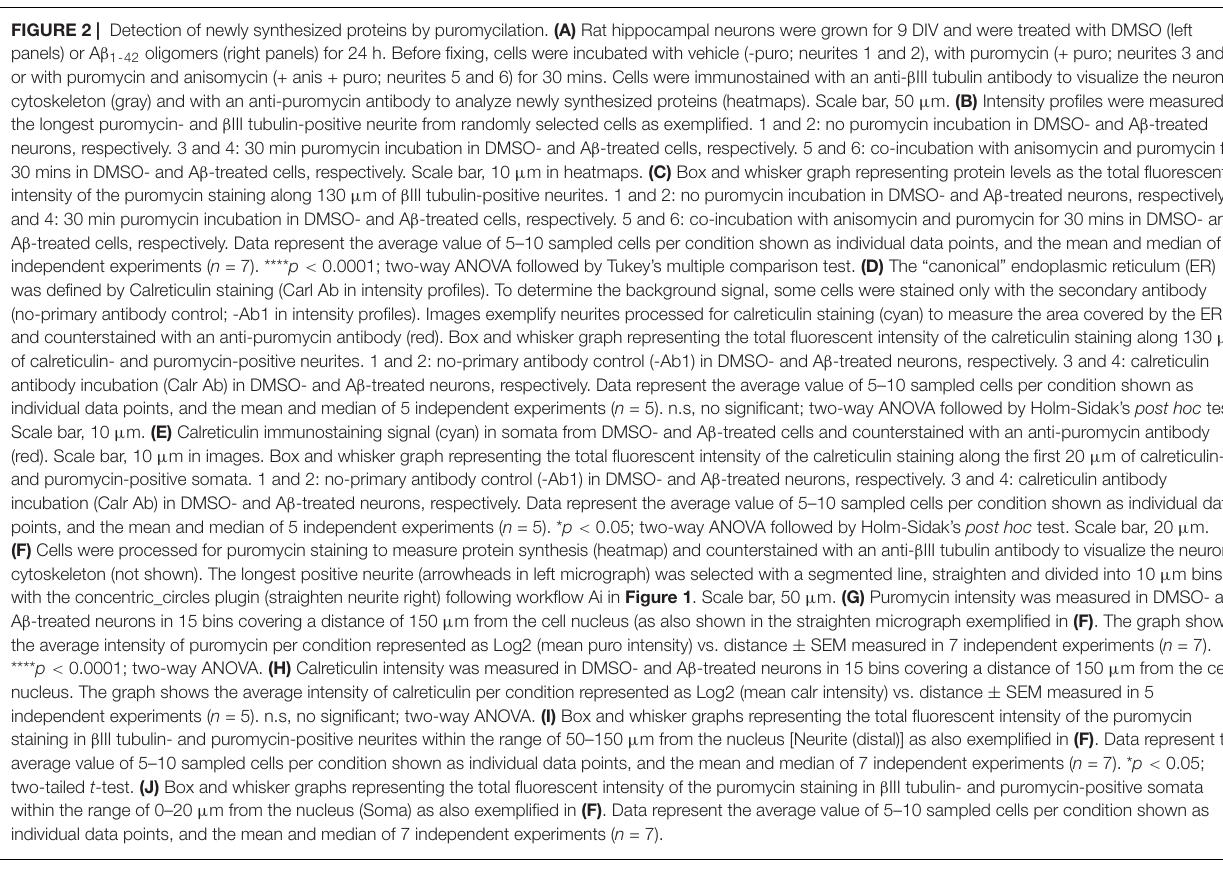
FIGURE 2 | Detection of newly synthesized proteins by puromycilation. (A) Rat hippocampal neurons were grown for 9 DIV and were treated with DMSO (left panels) or A β 1 - 42 oligomers (right panels) for 24 h. Before fixing, cells were incubated with vehicle (-puro; neurites 1 and 2), with puromycin (+ puro; neurites 3 and 4) or with puromycin and anisomycin (+ anis + puro; neurites 5 and 6) for 30 mins. Cells were immunostained with an anti- β III tubulin antibody to visualize the neuronal cytoskeleton (gray) and with an anti-puromycin antibody to analyze newly synthesized proteins (heatmaps). Scale bar, 50 µ m. (B) Intensity profiles were measured in the longest puromycin- and β III tubulin-positive neurite from randomly selected cells as exemplified. 1 and 2: no puromycin incubation in DMSO- and A β -treated neurons, respectively. 3 and 4: 30 min puromycin incubation in DMSO- and A β -treated cells, respectively. 5 and 6: co-incubation with anisomycin and puromycin for 30 mins in DMSO- and A β -treated cells, respectively. Scale bar, 10 µ m in heatmaps. (C) Box and whisker graph representing protein levels as the total fluorescent intensity of the puromycin staining along 130 µ m of β III tubulin-positive neurites. 1 and 2: no puromycin incubation in DMSO- and A β -treated neurons, respectively.